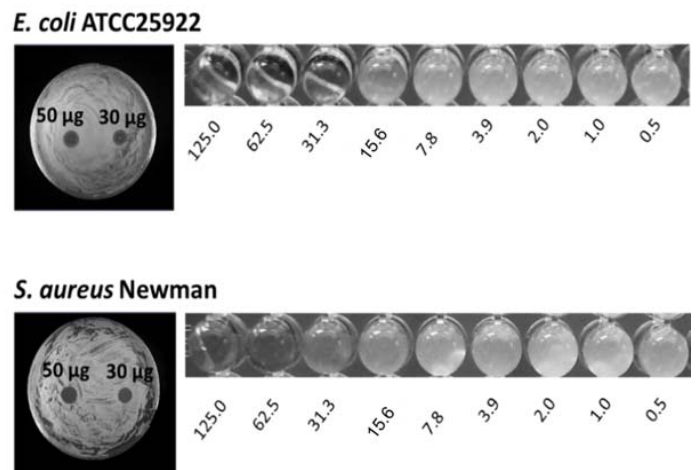
Figure 6. Photographs illustrating results from the assessment of complex 1 antibacterial activity towards E. coli ATCC25922 or S. aureus Newman by the disk diffusion method and MIC determination by broth microdilution assays. Circular growth inhibition zones are visible in plates spotted with 50 or 30 μ g of the complex. The numbers below the wells indicate the respective complex 1 final concentration, in μ g/mL. Photographs (not at the same scale) taken after 24 h of incubation at 37 °C.